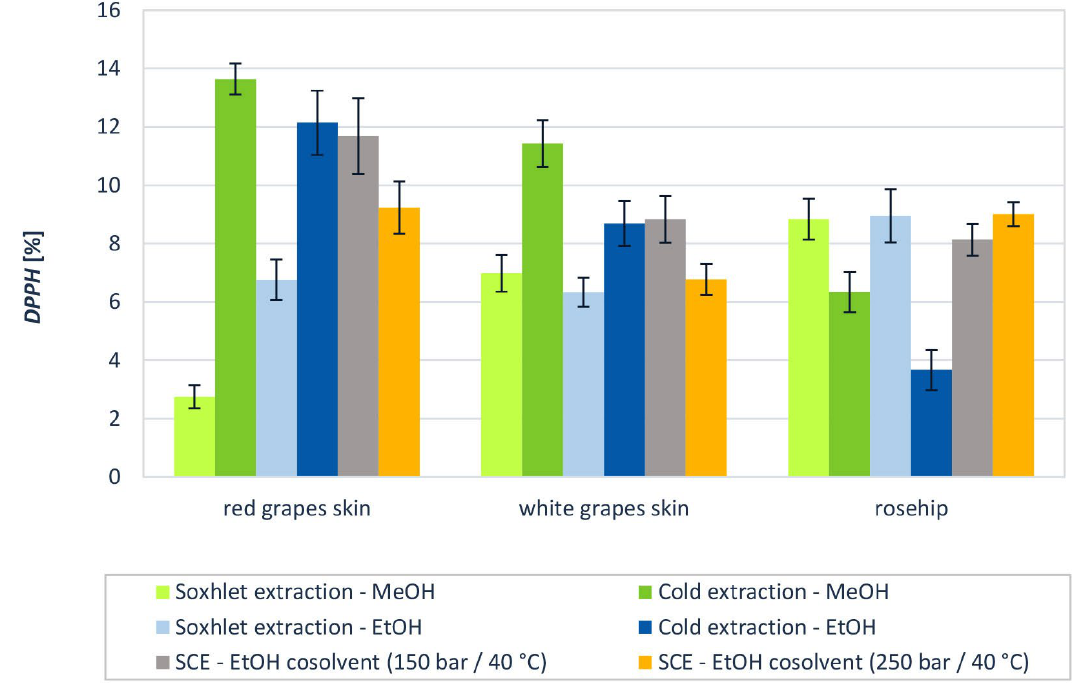
Figure 4: Comparison DPPH activity in % using different extraction